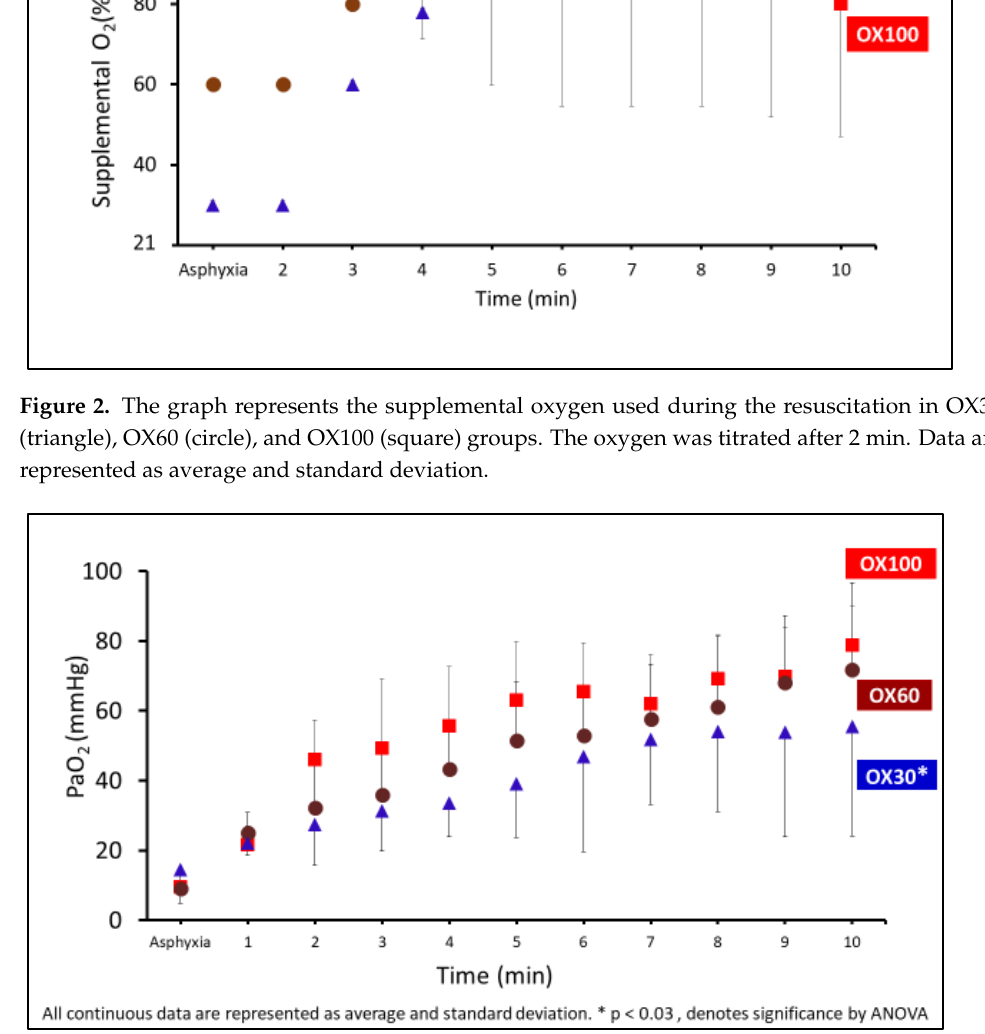
Figure 3. The graph shows the arterial oxygenation (PaO 2 ) in mmHg on the y ‐ axis and the events in min on the x ‐ axis. The PaO 2 was significantly lower in the OX30 (triangle) group (* p = 0.03 by ANOVA). Data are represented as average and standard